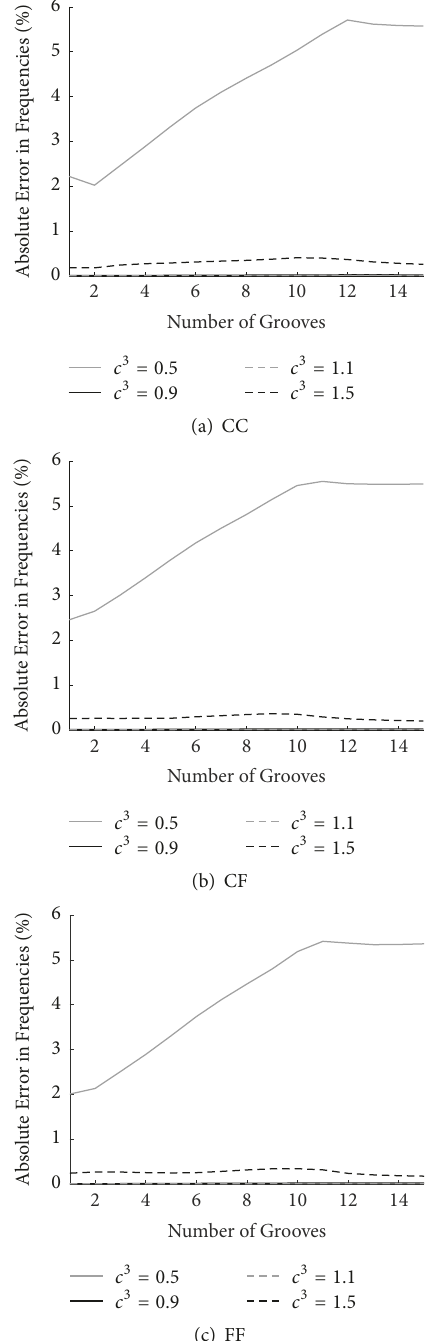
Figure 14: Frequency errors for variable groove number and second-order gradient